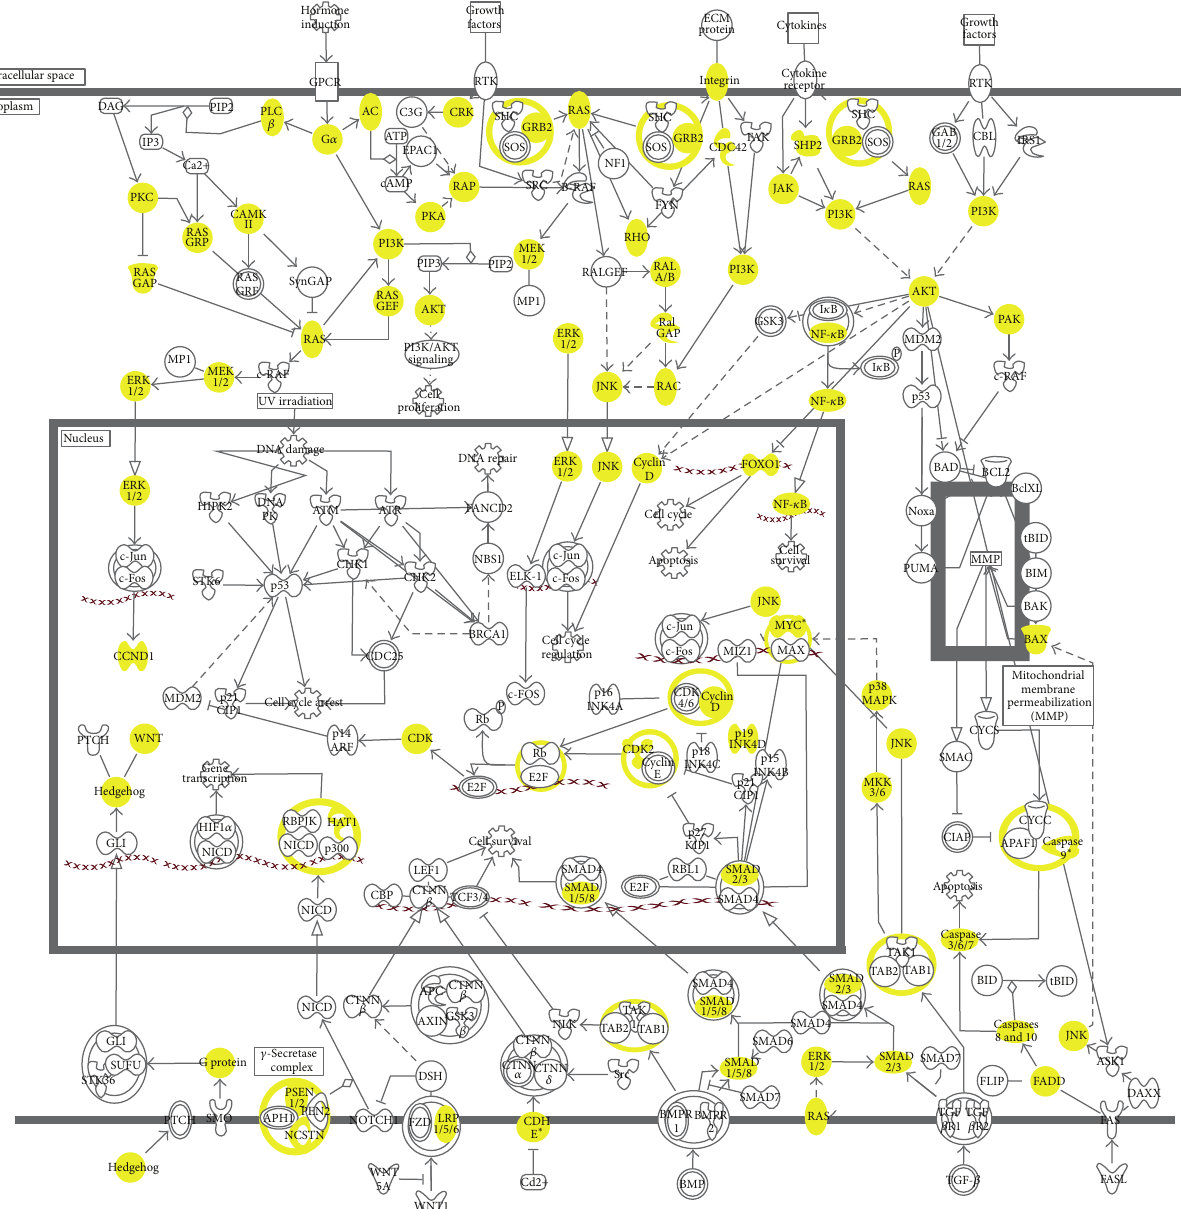
Figure 5: The major pathways involved in the molecular mechanisms of cancer as adapted from Ingenuity Pathway Analysis (IPA) database. The highlighted proteins in yellow depict our identified proteins from our 2D-LC-MS/MS analysis. A total of 77 proteins from our identified dataset from our 2D-LC-MS/MS are associated with the molecular mechanisms of